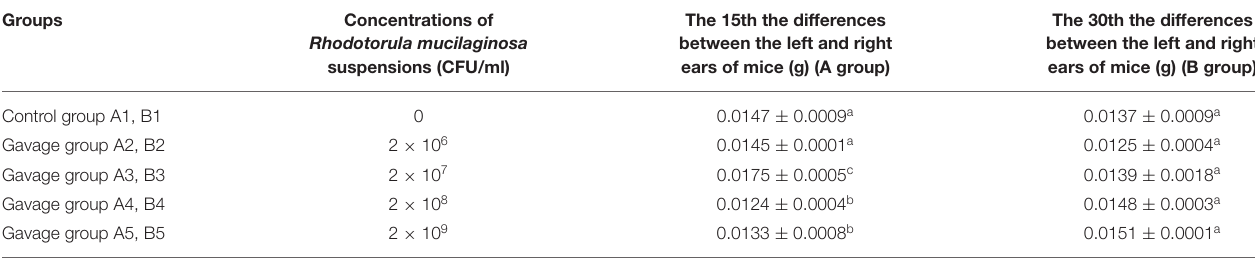
TABLE 2 | Effects of R. mociliginosa on delayed hypersensitivity (DTH) in mice. Groups